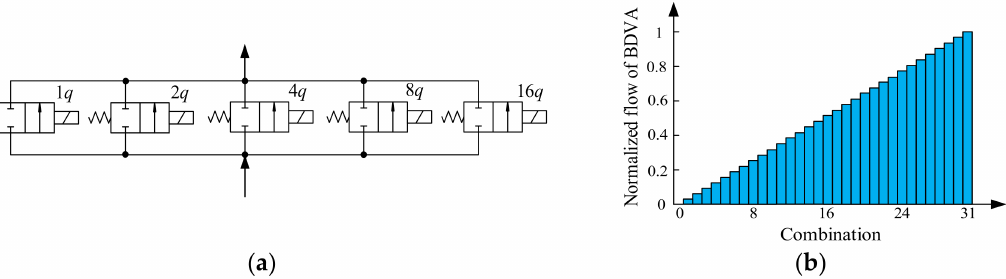
Figure 2. Schematic diagram and normalized flow of the BDVA: ( a ) Schematic diagram; ( b ) Normal- ized